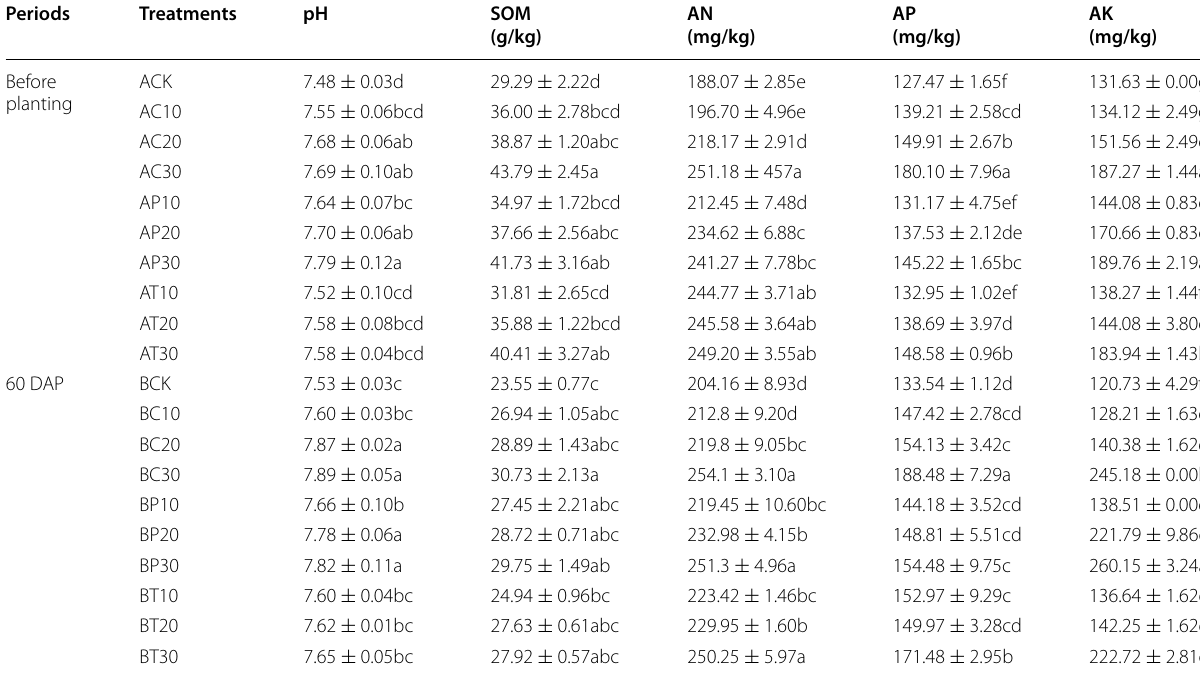
Table 2 Soil chemical properties analysis of vegetable residues application and continuous cropping